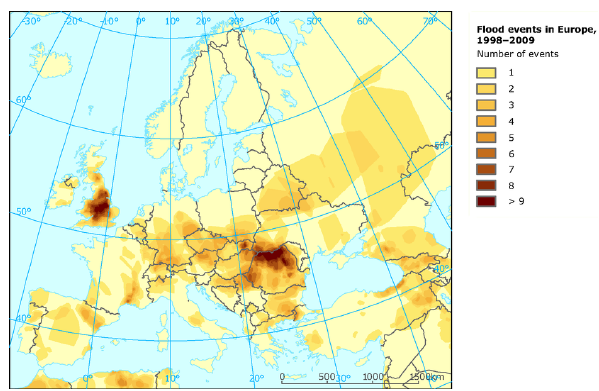
Figure 1. Occurrence of major floods in Europe in the period 1998– 2009; Source: http://www.eea.europa.eu/legal/copyright). Copy- right holder: European Environment Agency